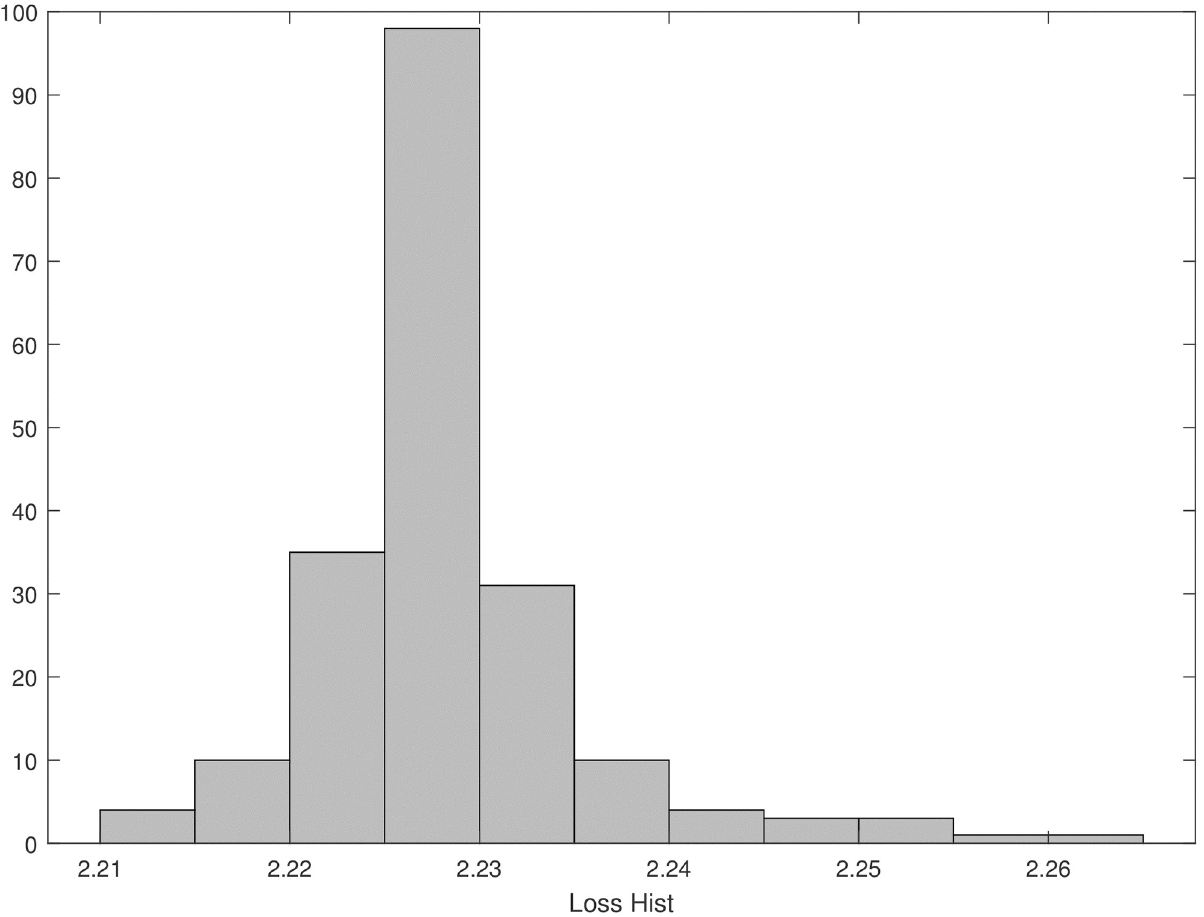
Fig 7. Loss function. Distribution of the loss function values obtained from the 200 optimization procedures of STEP 4.